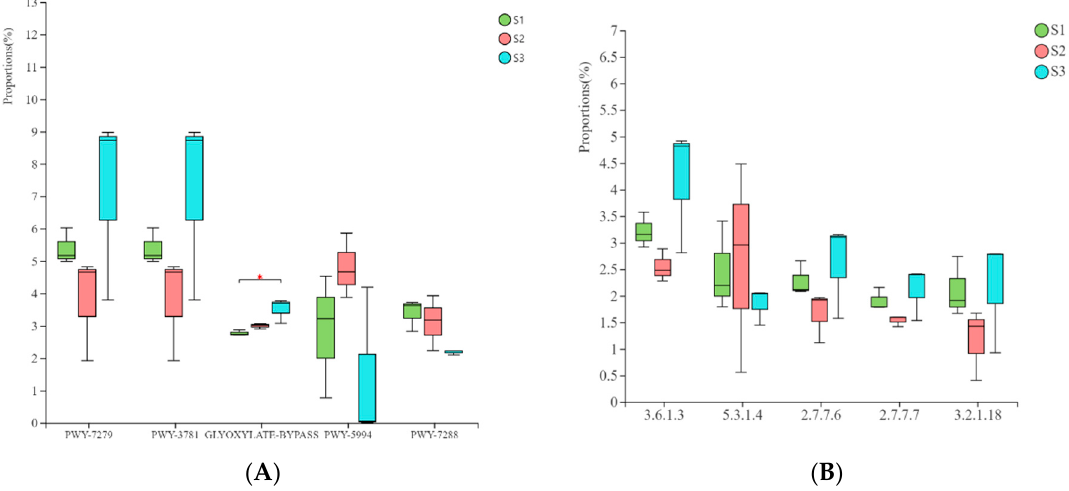
Figure 11. One − way ANOVA of metabolic pathway(A) and enzymes(B) in naturally fermented paocai, * p < 0.05.